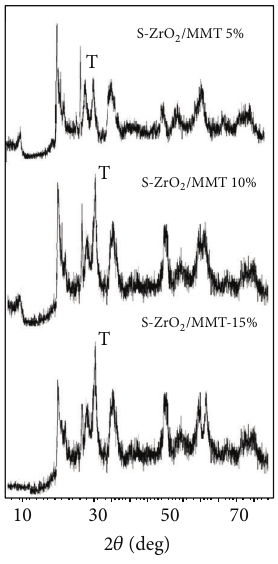
Figure 2: XRD pattern of S-ZrO 2 /MMT.